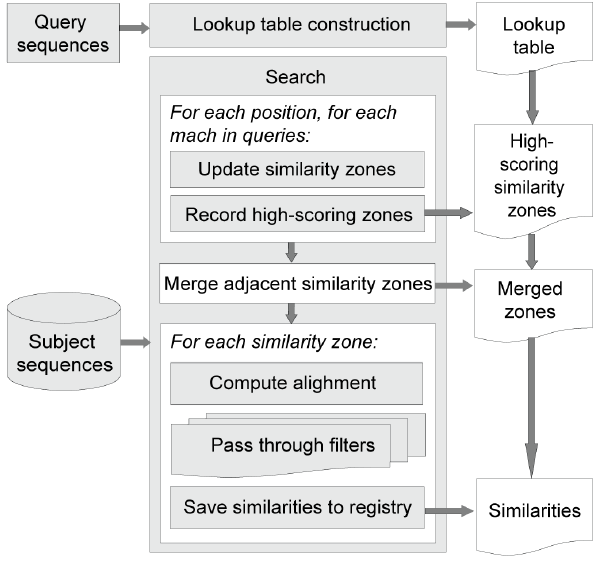
Figure 1. Block-scheme for PSimScan algorithm. Similarity detection in PSimScan is organized as a pipeline of hit accumulators and filters connected in the order of increasing computational